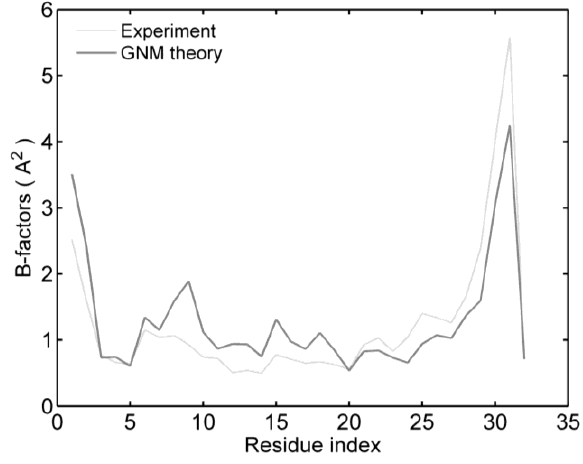
Figure 2. Experimental (light line) and calculated (dark line) B-factors of